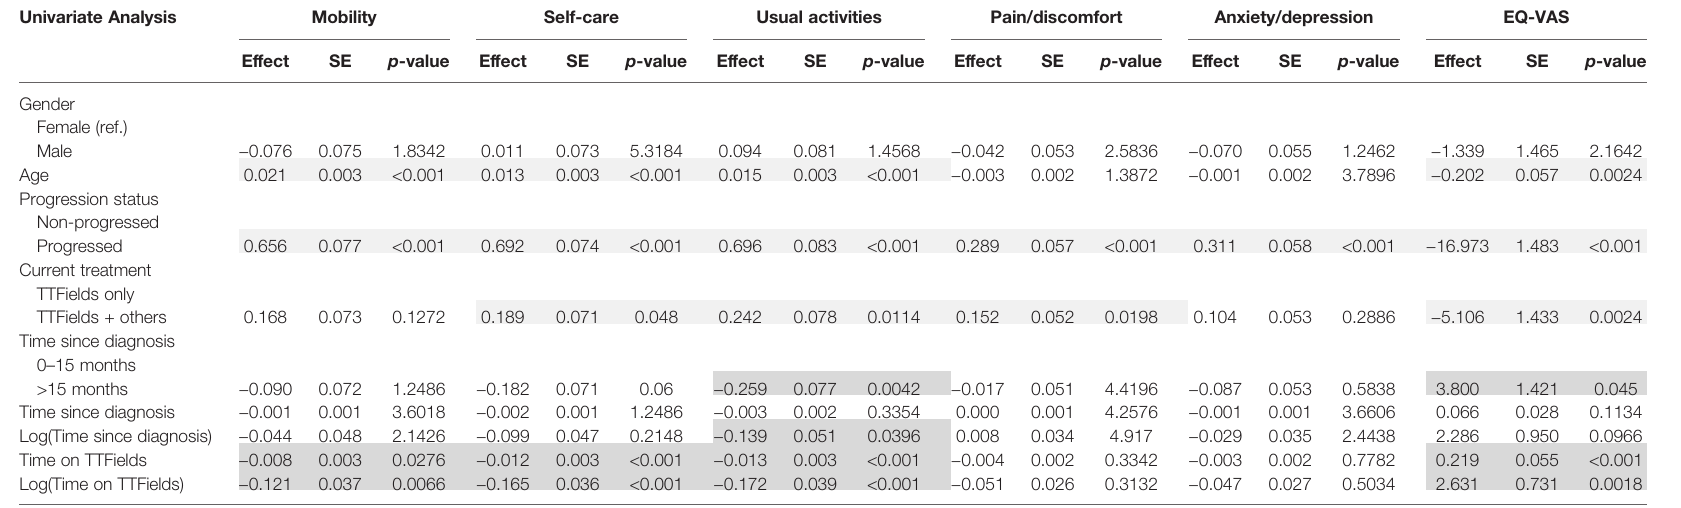
TABLE 3 | Univariate regression results. Univariate Analysis